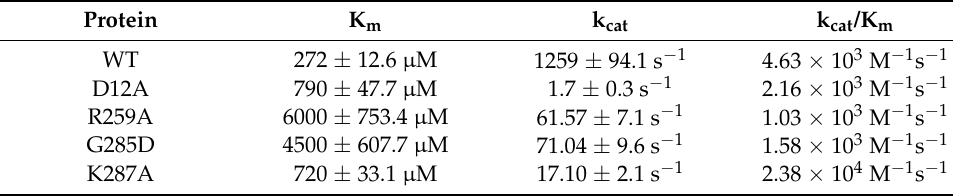
Table 2. Kinetic parameters of wt and mutant PyapApases. Protein K m k cat k cat /K